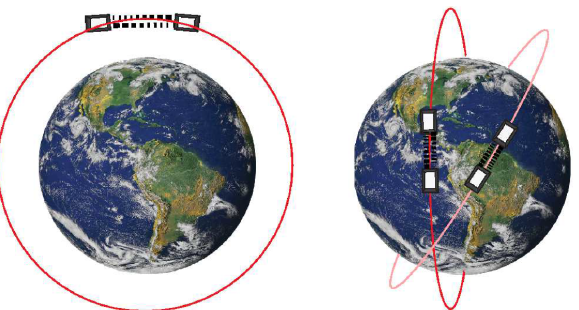
Figure 5. Illustration of a GRACE-type ( left ) and a Bender-type ( right ) flight formation. This figure is extracted from